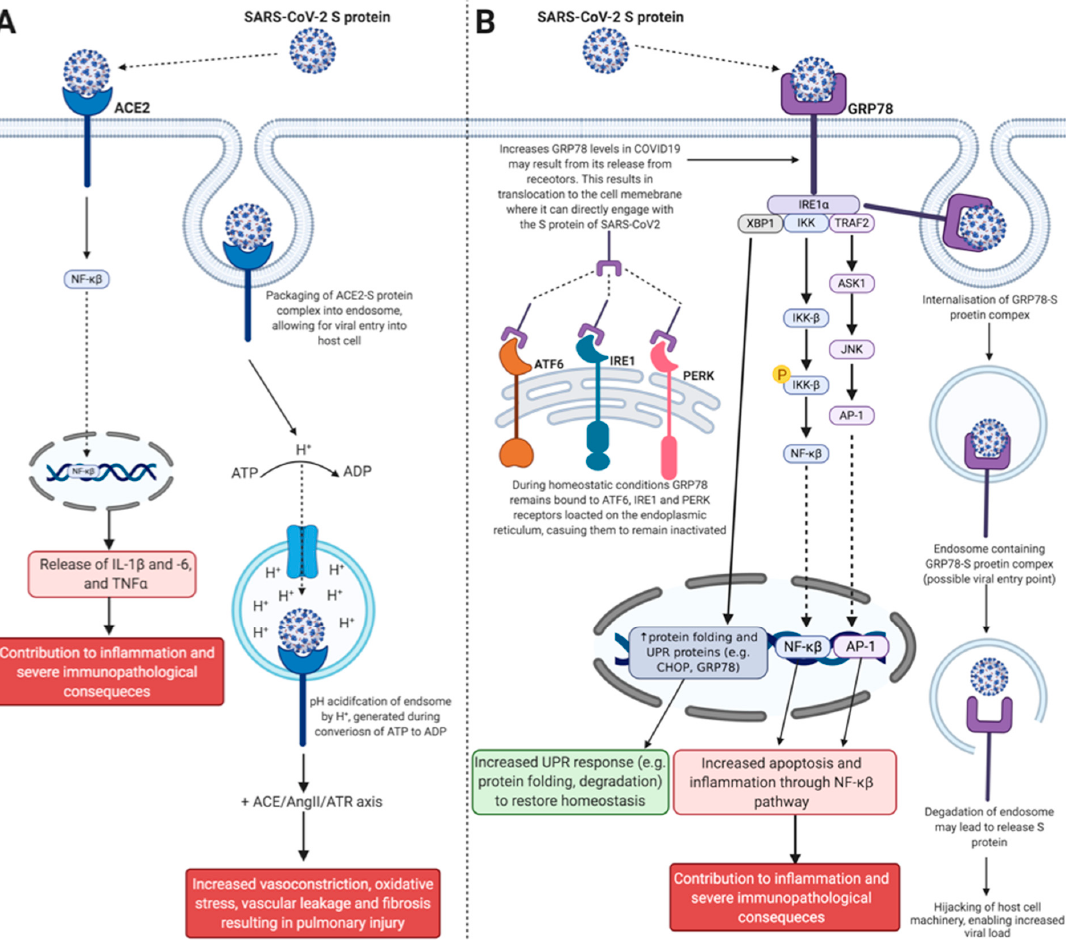
Figure 2. ( A ) Proposed involvement of angiotensin-converting enzyme 2 in SARS-CoV-2 infection. The receptor binding motif of S protein interacts with ACE2 [25], resulting in endocytosis by host cells [26]. Patients with severe COVID-19 have increased levels of IL-1beta, IL-6, and TNF-alpha [45,46], which may be released by NF-kB driven activation, resulting in contribution to immunopathological outcomes [45,46]. Up-regulation of ACE/AngII/AngII type 1 receptor axis may also result in vasoconstriction and pulmonary lung injury [41]. ( B ) Involvement of glucose-regulated protein 78 (GRP78) in SARS-CoV-2 infection. Under homeostatic condition GRP78 remains bound to ATF6, IRE1, and PERK in the endoplasmic reticulum [36]. Increased GRP78 levels have been reported in COVID-19 patients [47,48], suggesting that GRP78 is liberate from its receptors, and translocates to the cell membrane. In fact, GRP78 directly interacts with SARS-CoV-2 S protein [36]. Coupled with the ability of GRP78 to bind to and internalize viral fragments [49], we propose that GRP78 may present a viral entry point exploited by SARS-CoV-2 virus. Abbreviations: activator protein-1, AP-1; adenosine diphosphate, ADP; adenosine triphosphate, ATP; apoptosis signal-regulating kinase 1, ASK1; activating transcription factor 6, ATF6; C/EBP homologous protein, CHOP; hydrogen ion, H+; inhibitor of nuclear factor kappa-beta kinase subunit, IKK; inositol-requiring enzyme-1, IRE1; Jun N-terminal kinase, JNK; X-box-binding protein 1,